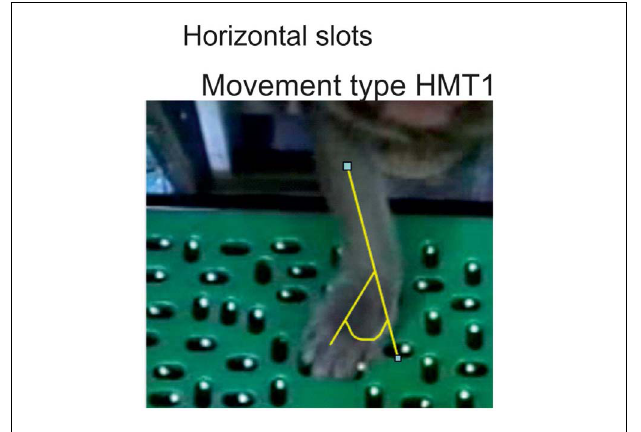
FIGURE 4 |When using the movement type 1 (HMT1) to retrieve a pellet from a horizontal slot, the wrist adduction was assessed quantitatively by measuring the angle as illustrated in yellow .